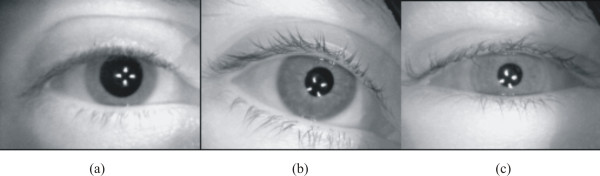
Recorded IR-illuminated images of the eye of three subjects showing the pupil at its maximum mydriasis for (a) healthy volunteer, (b) diabetic subject without CAN, and (c) diabetic subject with CAN.